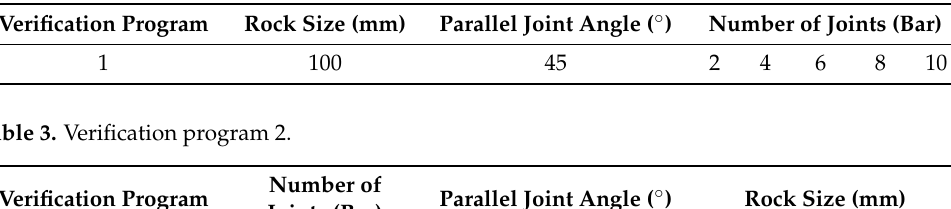
Table 3. Verification program 2.